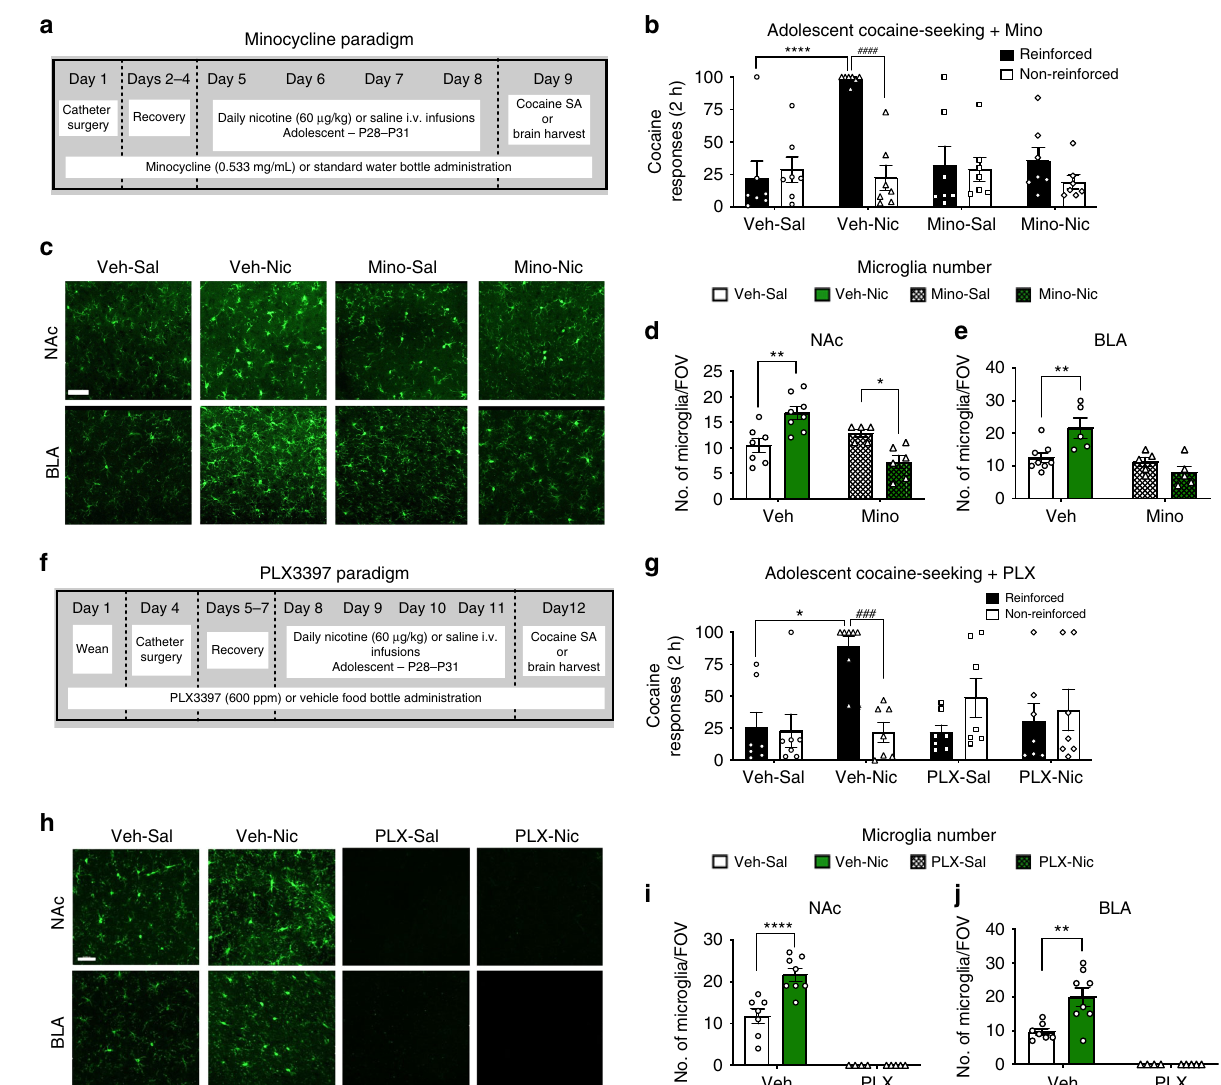
Fig. 4 Minocycline and PLX3397 block nicotine-induced increases in cocaine seeking. a Schematic of paradigm with nicotine pretreatment and minocycline water bottle administration. b Nicotine selectively increases cocaine responding ( F (1,24) = 26.55, p = < 0.0001; η 2 = 12.18%) and adolescent rats discriminate between reinforced and non-reinforced responses (#### p < 0.0001). There was a signi fi cant effect of response ( F (1,24) = 23.03, p < 0.0002; η 2 = 10.56%), interaction between response and minocycline ( F (1,24) = 7.163), p = 0.0132, η 2 = 3.286%) and interaction between response, nicotine, and minocycline exposure ( F (1,24) = 13.97, p = 0.0010, η 2 = 6.409%; n = 7). Minocycline blocked nicotine-induced increases in cocaine responding. c Representative images of IBA1 stained microglia in the NAc and BLA with saline or nicotine and vehicle or minocycline administration. d Minocycline administration eliminated nicotine-induced increases in NAc soma number ( F (1,22) = 7.95, p = 0.0100; η 2 = 14.14%). There was also a signi fi cant interaction between minocycline and nicotine administration ( F (1,22) = 21.84, p = 0.0001; η 2 = 39.66%) ( n = 7 vehicle-saline, 5 minocycline- saline, 8 vehicle-nicotine, 6 minocycline-nicotine). e Minocycline administration eliminated nicotine-induced increases in BLA soma number ( F (1,19) = 13.59, p = 0.0016; η 2 = 32.58%). There was also a signi fi cant interaction between minocycline and nicotine administration ( F (1,19) = 9.264, p = 0.0067; η 2 =